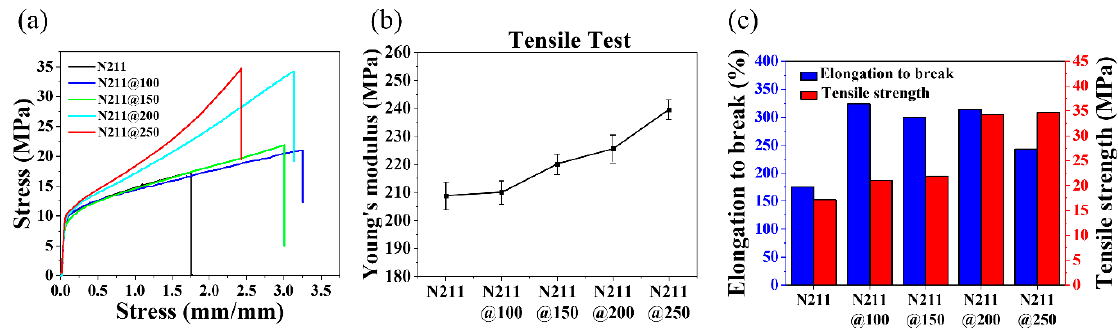
Figure 5. ( a ) Stress–strain curves of pristine and annealed membranes. ( b ) Plot for measured Young’s moduli of pristine and annealed membranes. ( c ) Plot for elongation to break values and tensile strengths of pristine and annealed membranes.